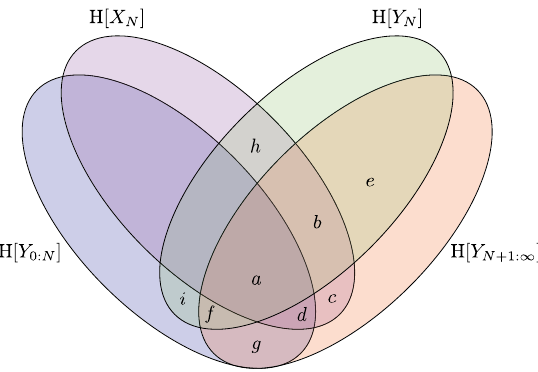
FIG. 8. Information diagram for dependencies between the input past Y 0 ∶ , next input Y , current ratchet state X N N